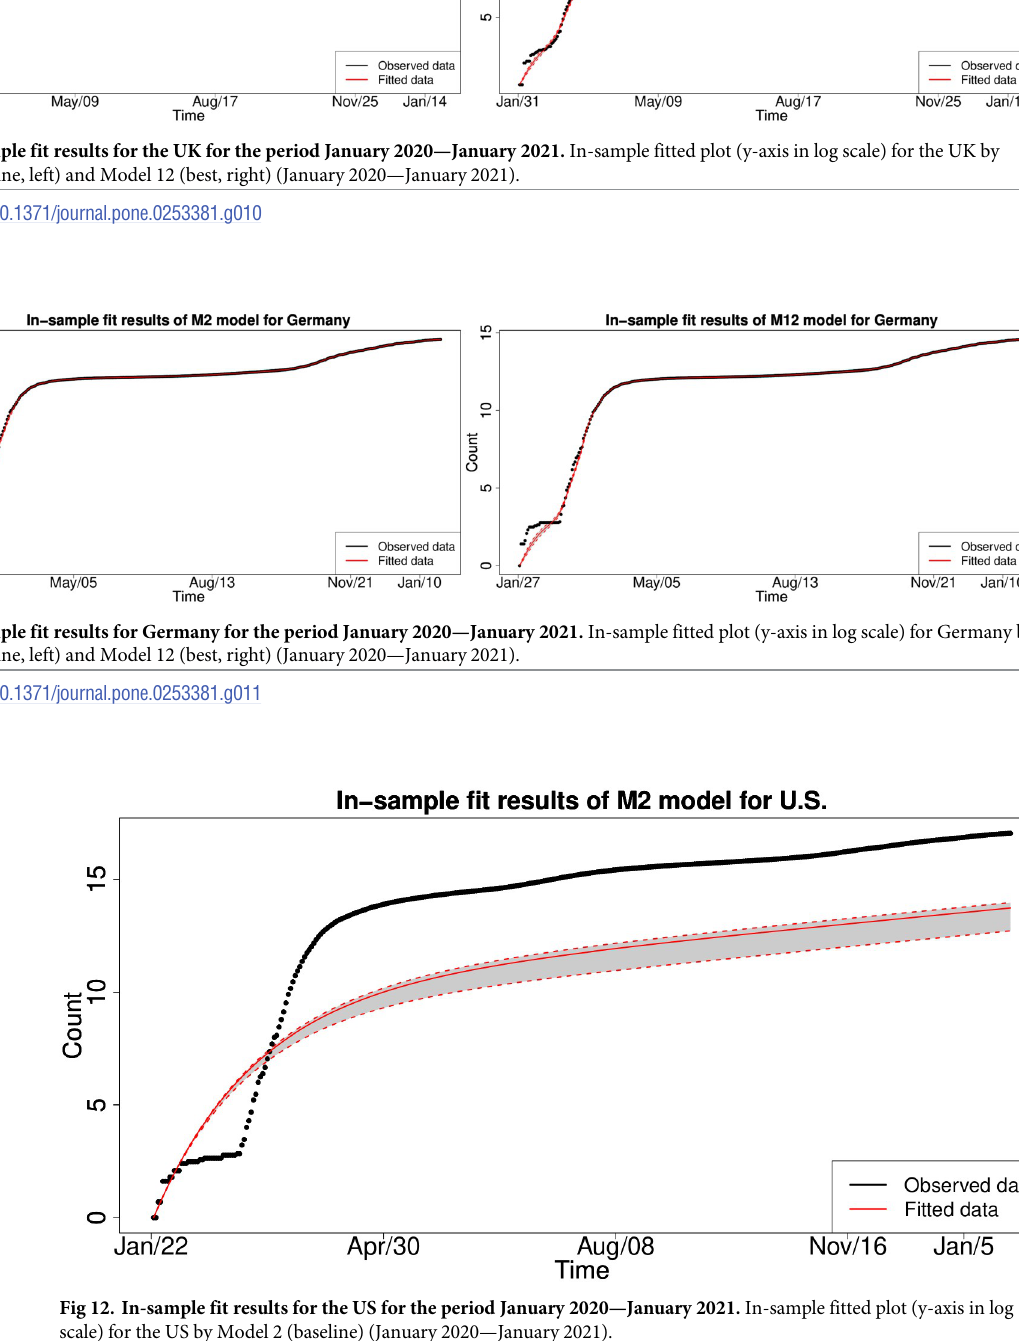
PLOS ONE | https://doi.org/10.1371/journal.pone.0253381 June 28, 2021 28 /